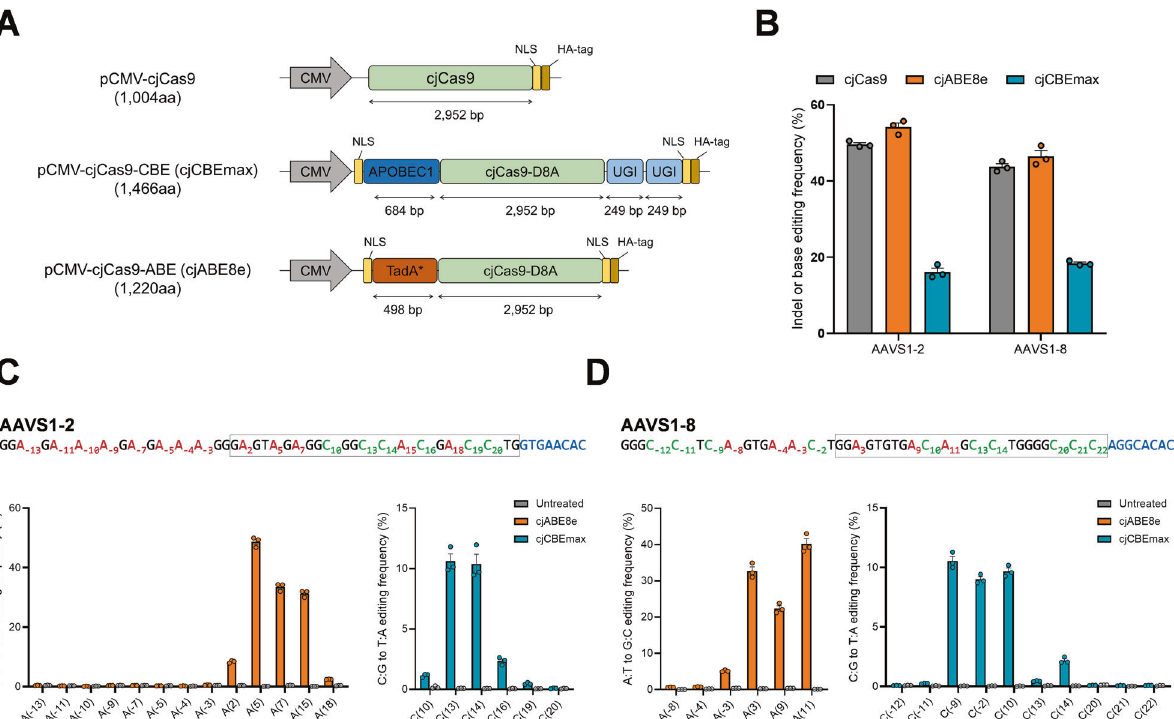
Fig. 1 Campylobacter jejuni Cas9-mediated cytosine and adenine base editing in human cells. A Schematic overviews of the constructs of cjCas9, cjABE8e, and cjCBEmax. cjCBE and cjABE consist of 1466 and 1220 amino acid residues, respectively. B Mutation frequencies of cjCas9, cjABE, and cjCBE at the endogenous AAVS1-2 and AAVS1-8 target sites in HEK293T cells. Base editing frequency of individual adenine and cytosine bases within a 37-nt window, 22-nt of spacer, and 15-nt outside the spacer sequence, around the ( C ) AAVS1-2 target site and the ( D ) AAVS1-8 site. Within the 37-nt window, adenine and cytosine are highlighted in red and green, respectively, and the spacer sequences and PAM of gRNAs are indicated in blue boxes, respectively. All experiments were conducted in biologically independent triplicates. Error bars indicate the standard error of the